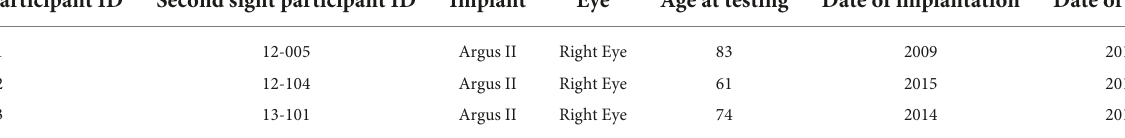
TABLE 1 Patient demographics.